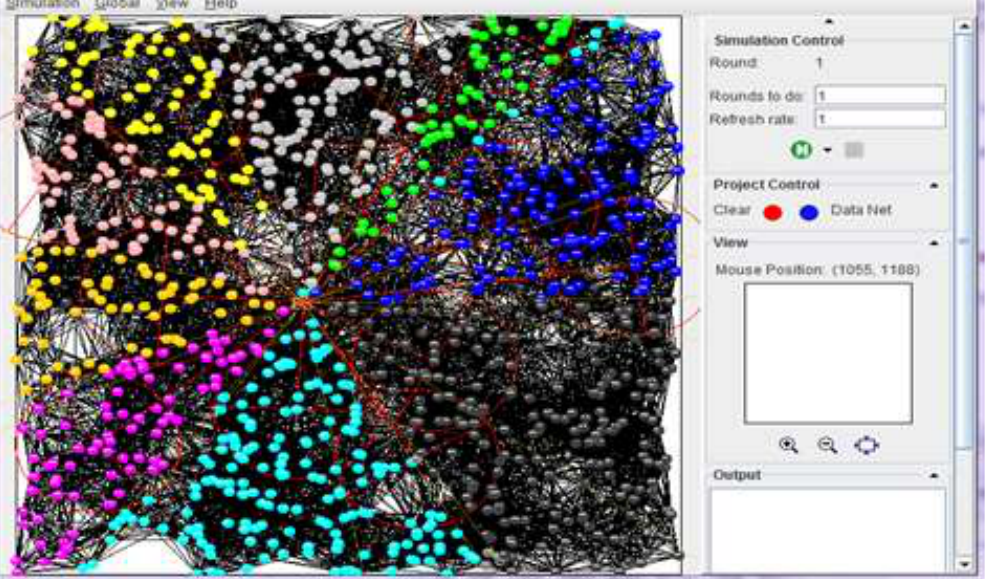
Figure 4. The sink partitions the network into sectors.